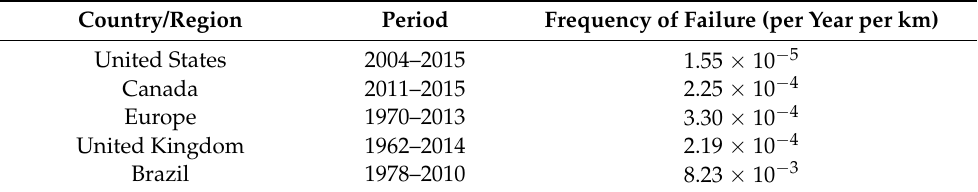
Table 1. Pipeline failure